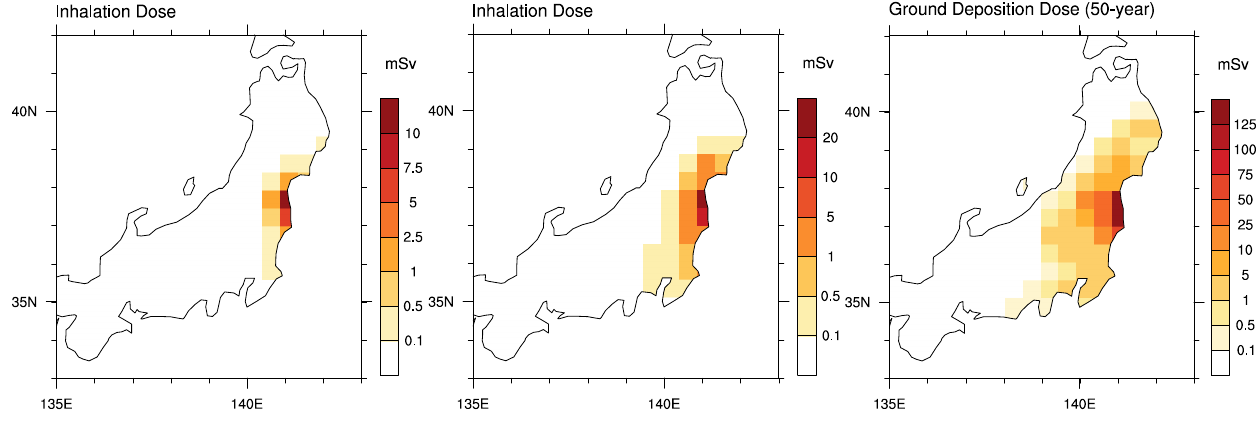
Fig. 9. Effective dose from the inhalation of airborne radionuclides for the nominal emission dataset (left); inhalation dose sensitivity test for the 131 I emission scaled by factor 5 (middle); and fifty-year dose from the ground deposition of 131 I , 134 Cs and 137 Cs (right) based on dose factors by the IAEA (2009).